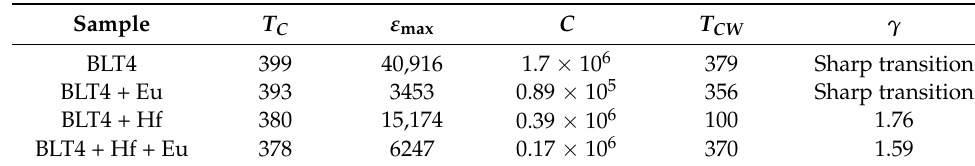
Table 5. Influence of the modificators on the dielectric parameters of BLT4 ceramics: T C —Curie temperature, ε max —maximum value of dielectric permittivity at T C , C —Curie constant, T CW —Curie– Weiss temperature, and γ —diffuseness parameter.